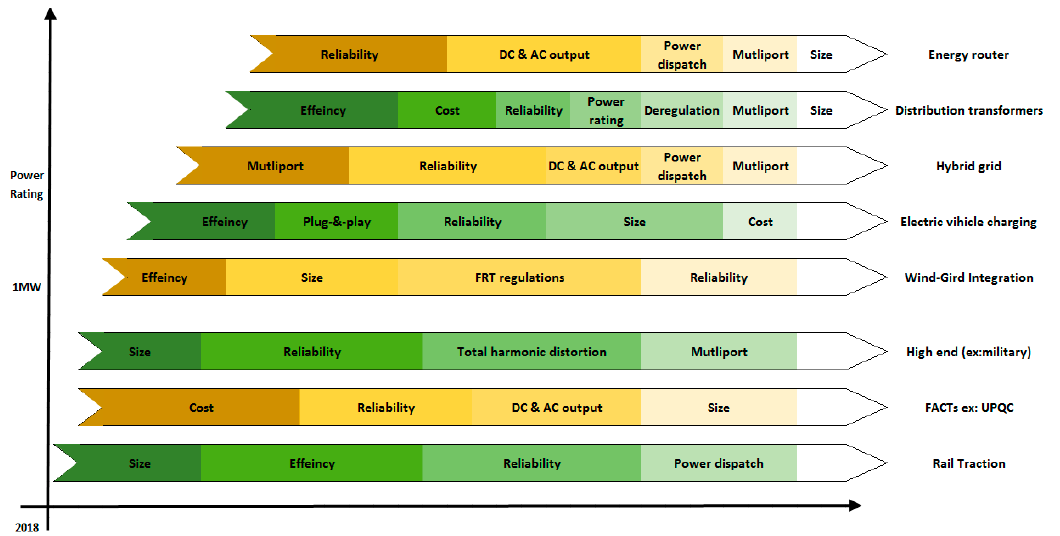
Figure 9. Market drivers on timeline vs. power rating for different SST applications.